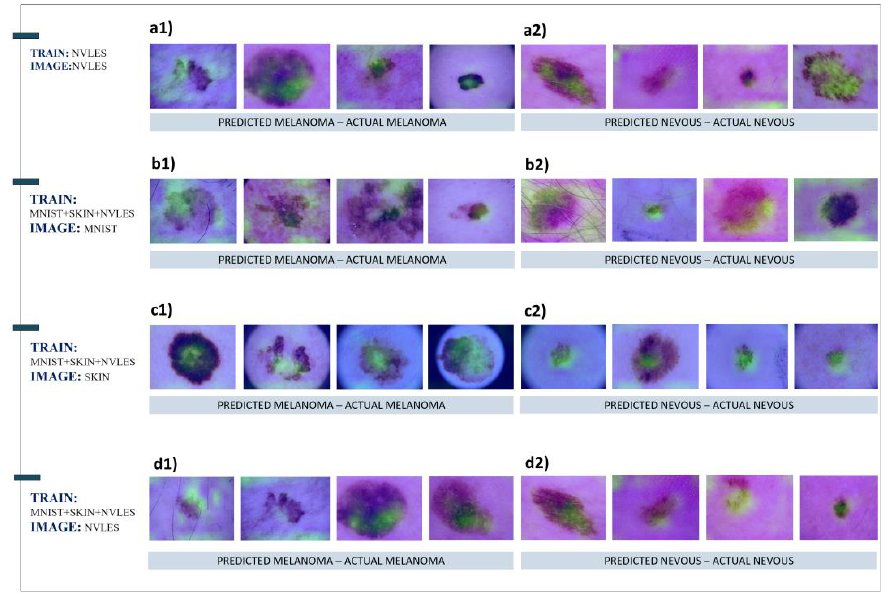
Figure 8. Grad-CAM results for the following test dataset samples: ( a ) NVLES, ( b ) MNIST, ( c ) SKIN, and ( d ) NVLES.